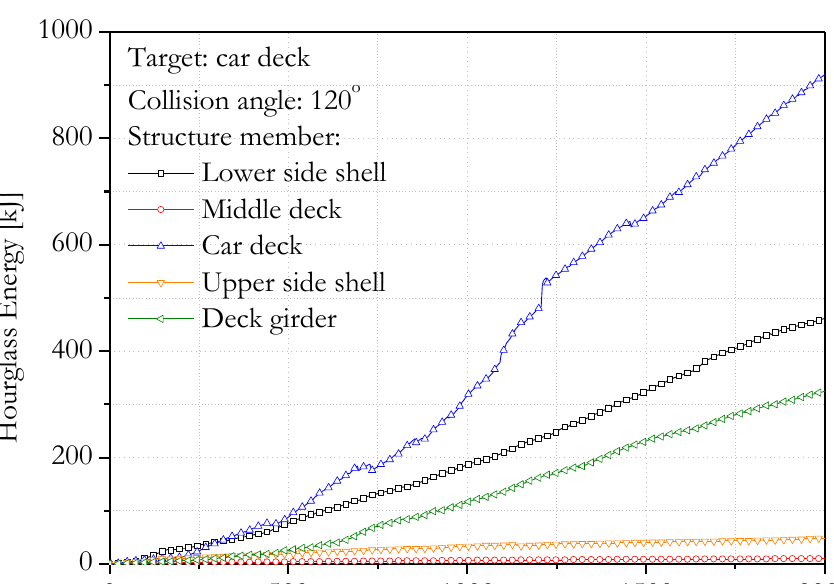
Figure 8. Hourglass energy of the collision angle 90°.